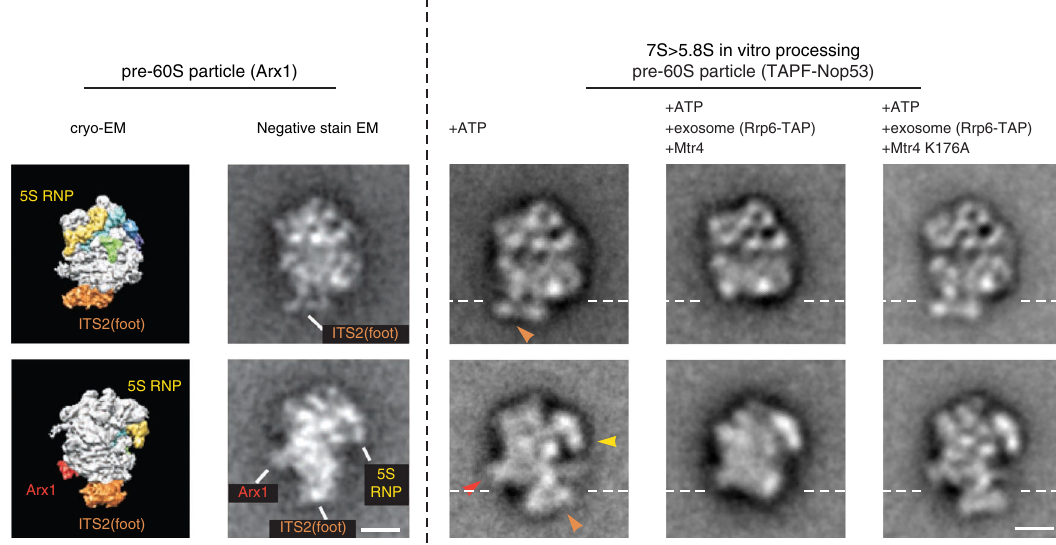
Fig. 4 Detection of 'foot' structure removal from pre-60S particles. Negative-stain EM of the pre-60S particles (af fi nity-puri fi ed via TAPF-Nop53) after the in vitro processing reaction using endogenous yeast exosome (af fi nity-puri fi ed via Rrp6-FTpA) and recombinant wt Mtr4 or mutant Mtr4 (K176A), all in the presence of ATP. For control purposes, the pre-60S particle was also incubated with only ATP (mock). Shown to the left of the dashed line is the cryo- EM and negative-stain EM structure of the published Arx1-TAP particle (reproduced from ref. 25 ) in two orientations, rotated by 90° around the z -axis 25, 26 , which reveal structural hallmarks of the 7S pre-rRNA containing pre-60S particle: 'foot' (orange; ITS2 part of 7S pre-rRNA plus ITS2-associated factors), 5S RNP (yellow), Arx1 (red). Shown on the right are the two typical negative-stain EM classes of the pre-60S particles after the in vitro processing reaction, which correspond to the shown classes of the Arx1 particle. The pre-60S particles shown were derived from fraction 8 of the glycerol gradient (Fig. 3a). The orange, yellow and red arrowheads point to ITS2 (foot), 5S RNP and Arx1 structures, respectively. The white dashed horizontal lines mark where the 'foot' structure was removed from the core of the pre-60S particle upon in vitro 7S → 5.8S pre-rRNA processing. The scale bars represent 10 nm.